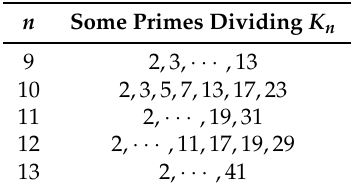
Table 1. Divisibility of K n